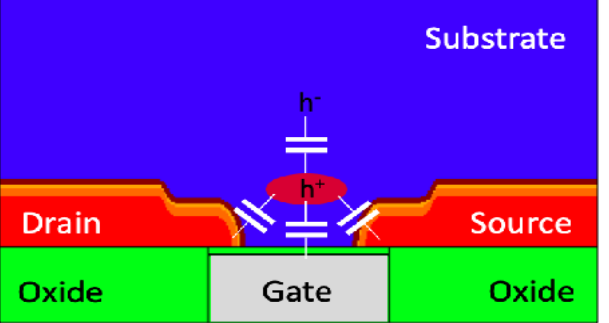
Figure 5. Schematic of dielectric coupling of self-mixing dipole toward electrodes of the metal–oxide– semiconductor field-effect transistor (MOS-FET) device.